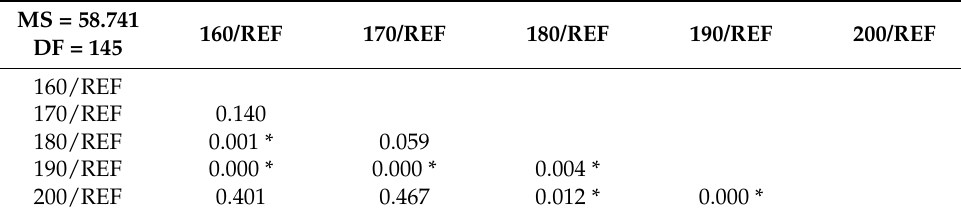
Table A9. Duncan ´ s multiple range test for changes in colour parameter b.